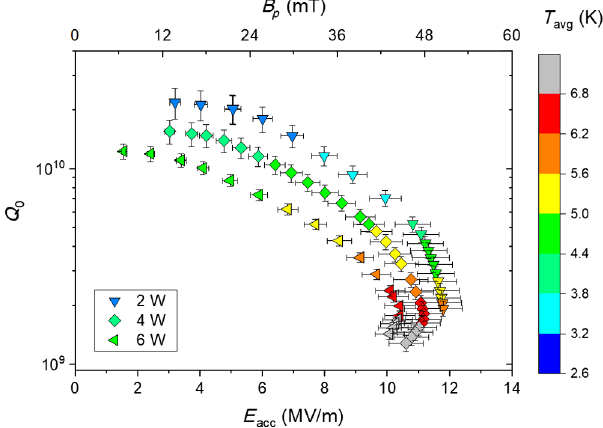
FIG. 25. Q 0 as a function of the rf field for the conduction- cooled prototype cavity measured at General Atomics after the second cooldown for different values of dc heat applied by HTR 6. All the data points were measured in steady-state conditions and the symbols ’ colors correspond to the average equator ring temperature. The cavity performance was limited by thermal instability beyond the lowest measured Q 0 -value, except for ¼ 2 W for which the cavity test was stopped before reaching P dc thermal instability.